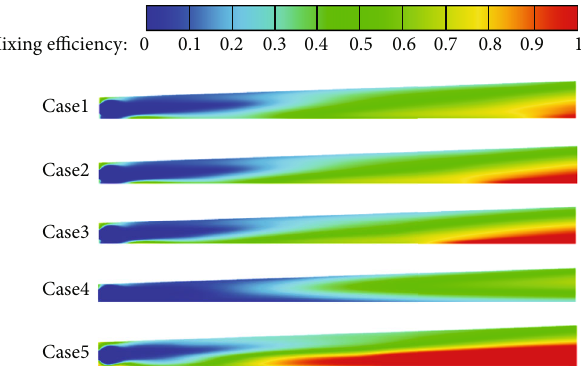
Figure 27: Mixing e ffi ciency for di ff erent cases at y = 0mm